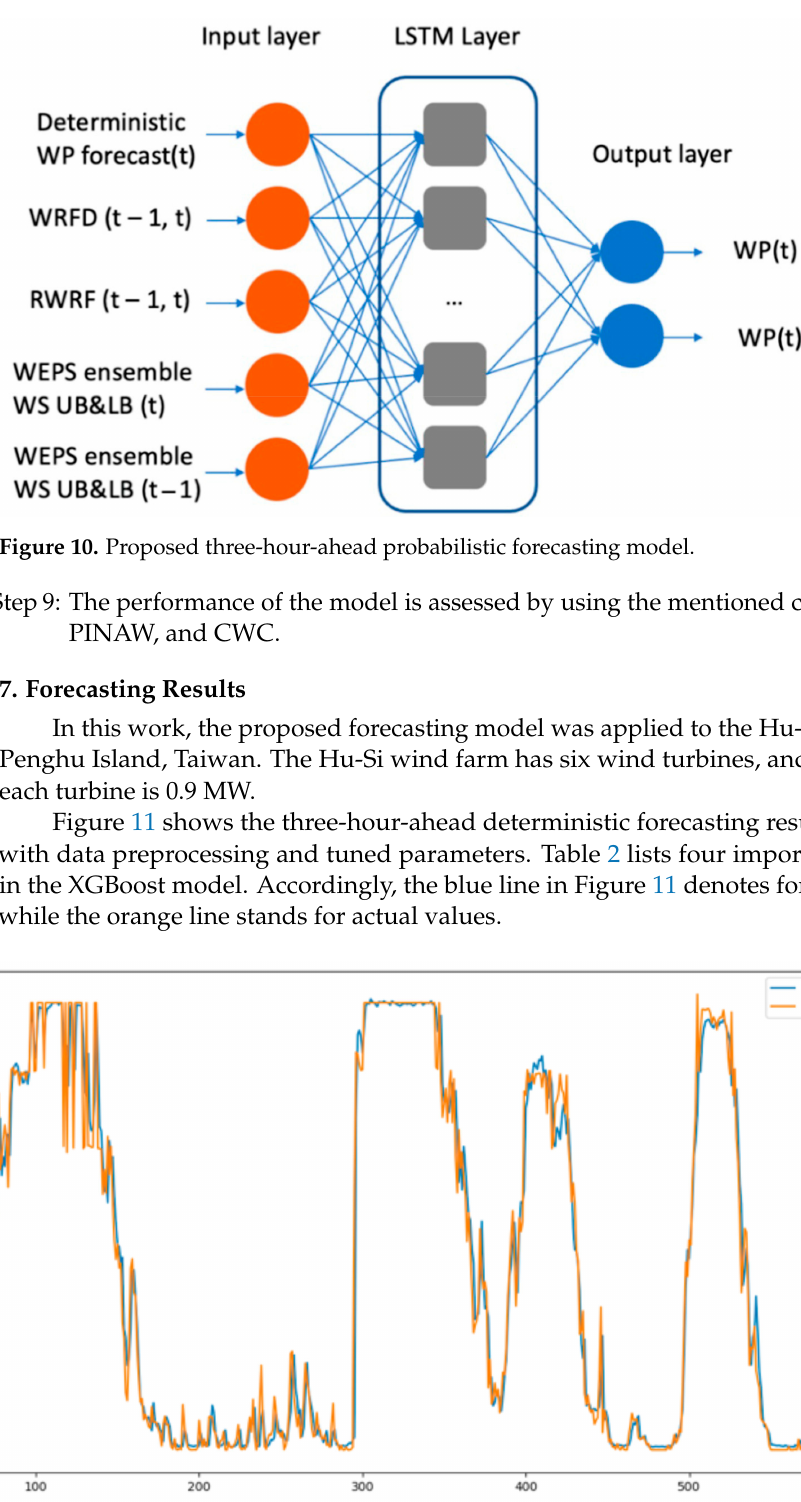
Figure 11. Testing sample of three-hour-ahead by the proposed